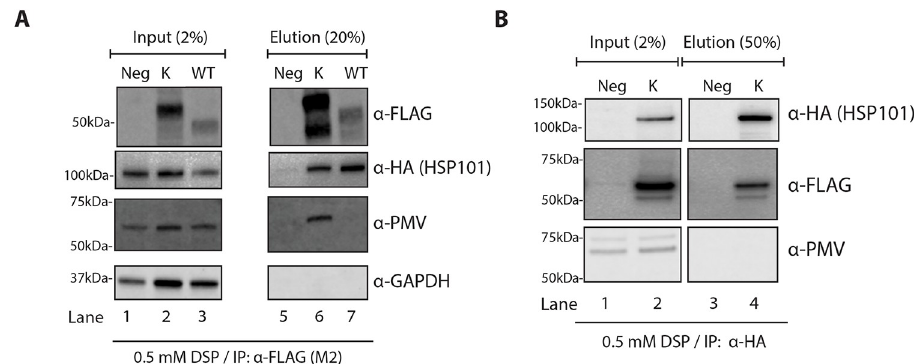
Fig 7. Plasmepsin V is not directly associated with HSP101 in the parasite ER. (A) Western blot analysis of WT and P5 Lys Hyp1-Nluc-mDHFR-3xFLAG (K) proteins captured with anti-FLAG M2 agarose beads indicate that the ER- trapped P5 Lys Hyp1-Nluc-mDHFR-3xFLAG associates with both HSP101 and plasmepsin V. Infected erythrocytes were magnetically purified then crosslinked with 0.5 mM DSP, lysed, and incubated with anti-FLAG M2 agarose beads. As a negative control, the HSP101-HA glmS parental parasites were treated similarly (Neg). Input (1.5%) and eluate (37.5%) were fractionated by SDS-PAGE. Immunoblot detection was performed using an anti-HA antibody to detect HSP101 as well as antibodies to plasmepsin V (PMV). Antibodies to GAPDH were used as a negative control. The result was reproducible in three independent experiments. (B) Western blot of immunoprecipitated HSP101-HA from parasites expressing P5 Lys Hyp1-mDHFR-3xFLAG and probed with anti-plasmepsin V indicate the protease is not directly associated with HSP101-HA. Input (2%) and eluate (50%) were fractionated by SDS-PAGE. The result was reproducible in two independent